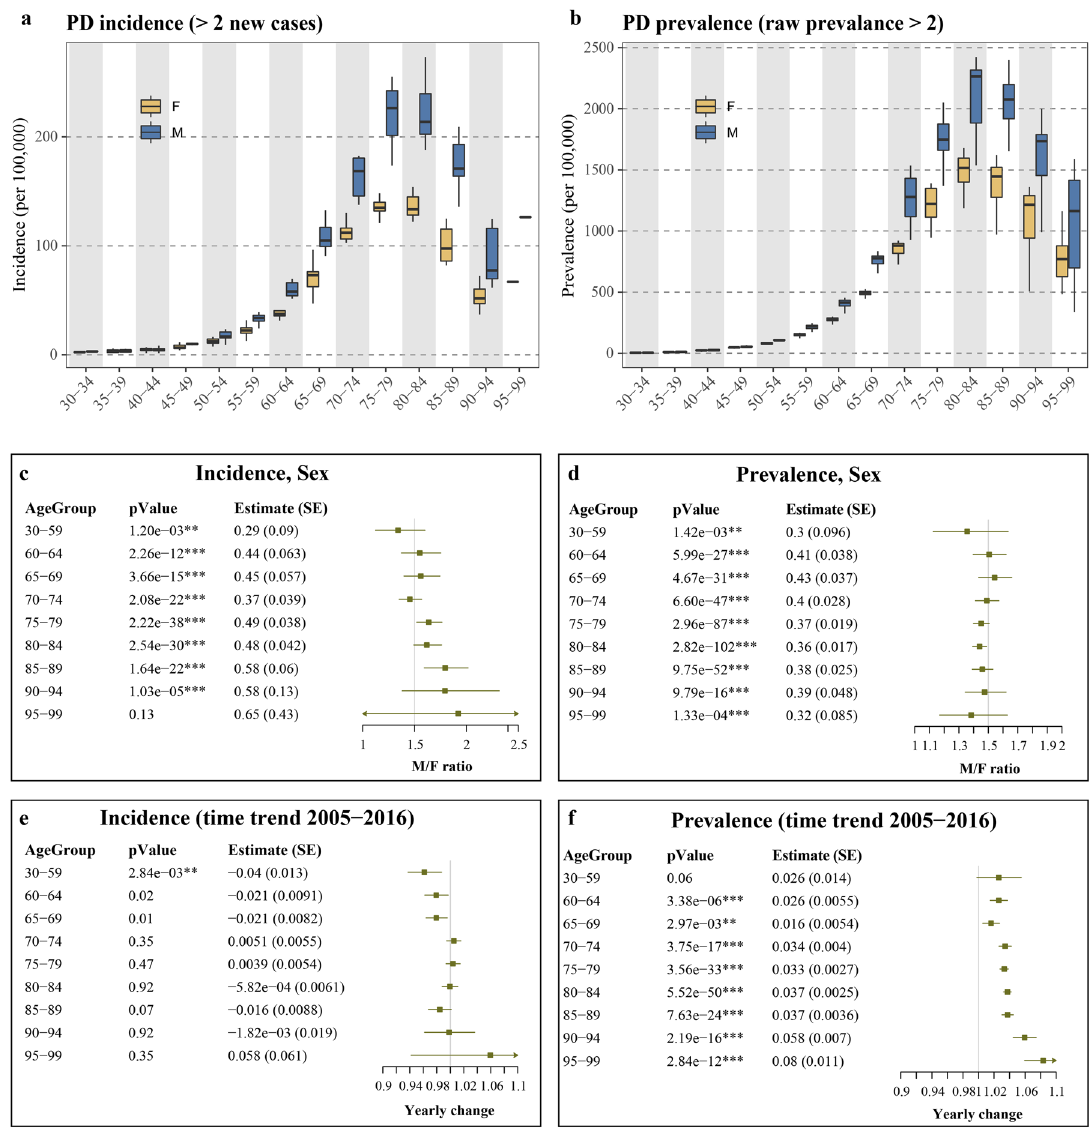
Fig. 1 Incidence and prevalence of PD in the Norwegian population during 2005 – 2016. a , b Incidence and prevalence were fi rst calculated for each observation year by dividing the number of new or total PD cases by the corresponding age- and sex-matched population size in the same year. For presentation purposes, the measures were summarized by age groups. Data points for which the number of new cases/raw prevalence were <2, were excluded. X-axis indicates the age group of the individuals. c – f The impact of sex ( c , d ) and time ( e , f ) were assessed individually for each age group, using Poisson regression. The p -values and the estimates for each covariate are shown in tables (for time trend, the estimate represents the natural log of the estimated change in each sequential year). SE, standard error. M/F ratio and Yearly change were derived by taking the exponential of the estimate for each covariate (sex or year). Lines represent the 95% con fi dence